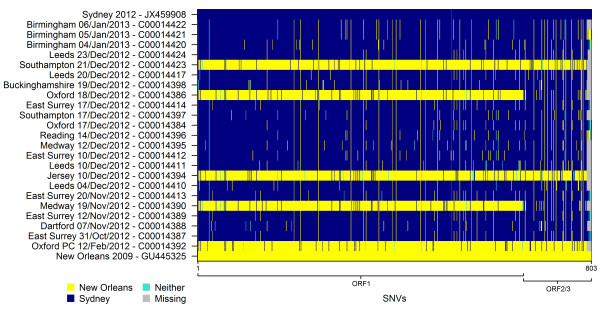
Graphical SNV matrix. Graph matrix depicting all 803 single nucleotide variants between New Orleans 2009 and Sydney 2012. Conserved sites within the genome have been removed in this depiction. Nucleotides identical to the Sydney 2012 variant are shown in blue, whilst nucleotides identical to New Orleans 2009 are depicted in yellow. Turquoise areas depict variants that are neither Sydney 2012 nor New Orleans 2009 like. Grey areas depict non assembled information.